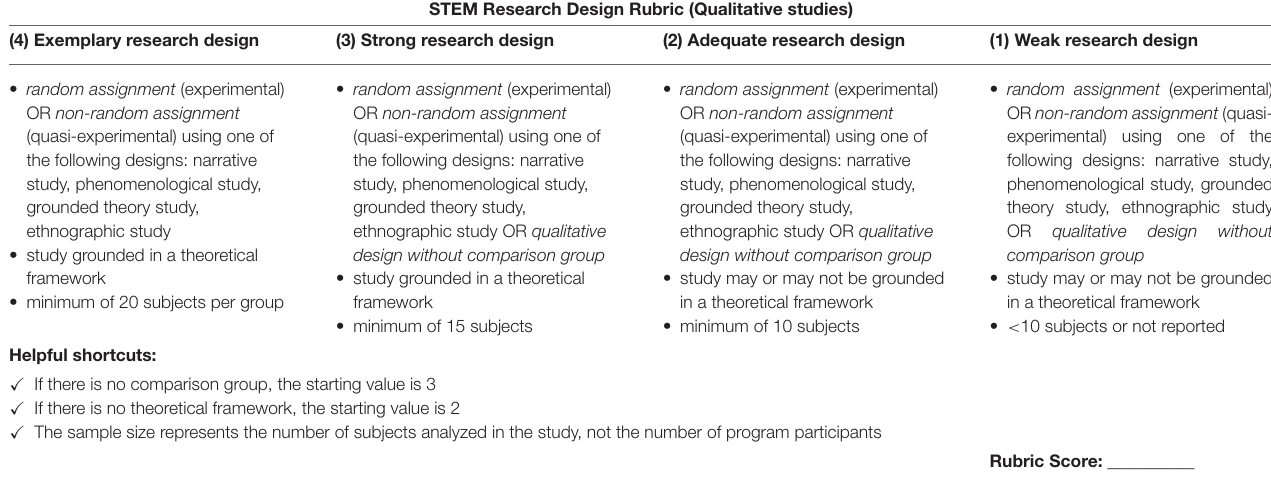
TABLE 4 | STEM research design rubric for qualitative